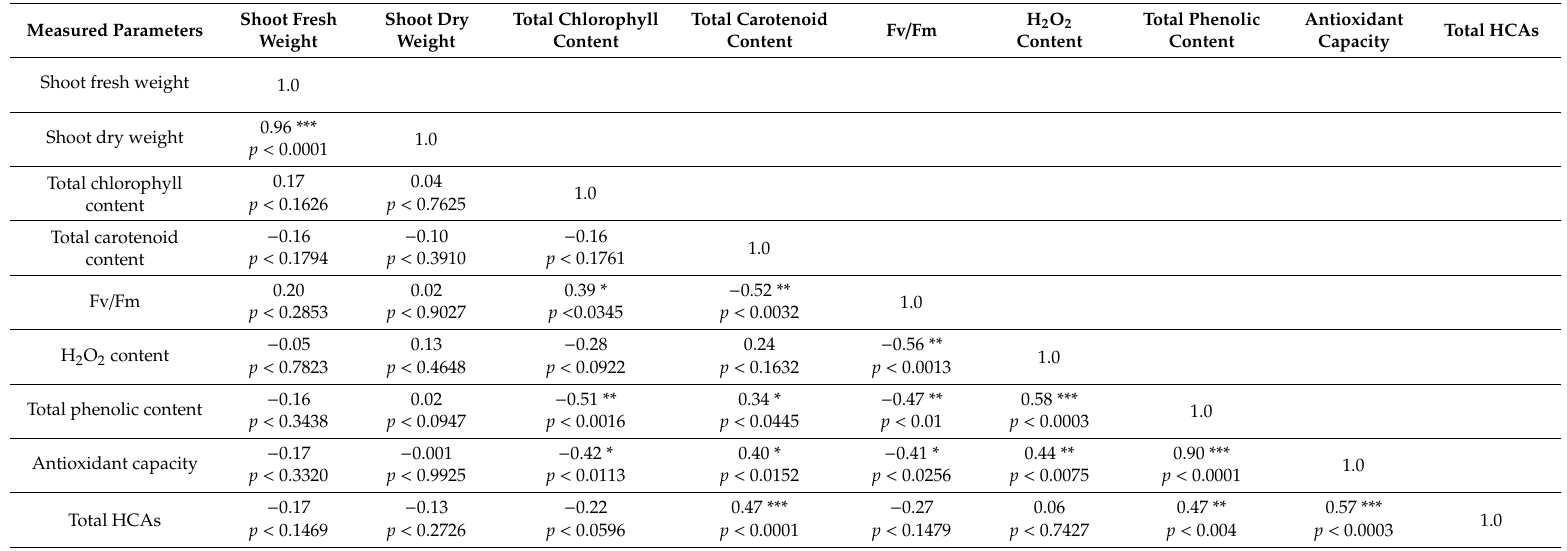
Table 3. Pearson correlation coe ffi cients between shoot fresh and dry weights, Fv / Fm (maximum quantum yield of photosystem II), total chlorophyll content, total carotenoid content, and total HCAs (hydroxycinnamic acids) per unit dry weight and H 2 O 2 content, total phenolic content, and antioxidant capacity per unit fresh weight of C. denticulatum at 4 days of UV-B treatment (0, 0.1, 0.25, 0.5, 1.0, and 1.25 W m − 2 ). The asterisk indicates significant di ff erence at * p < 0.05, ** p < 0.01, and *** p <